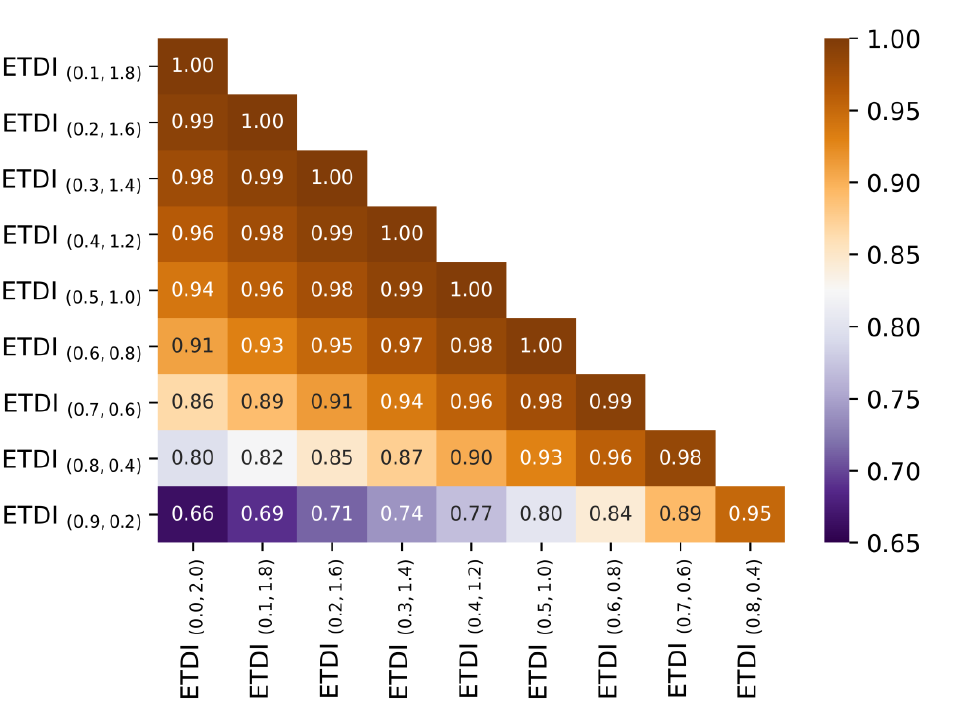
Figure 5. Pearson correlation coefficients between evapotranspiration deficit indices (ETDIs) at point P1 for various ( α , β )-parameter combinations. Table 2. Drought events, total drought durations, and duration per event at point P1 for various ( α , β )-parameter